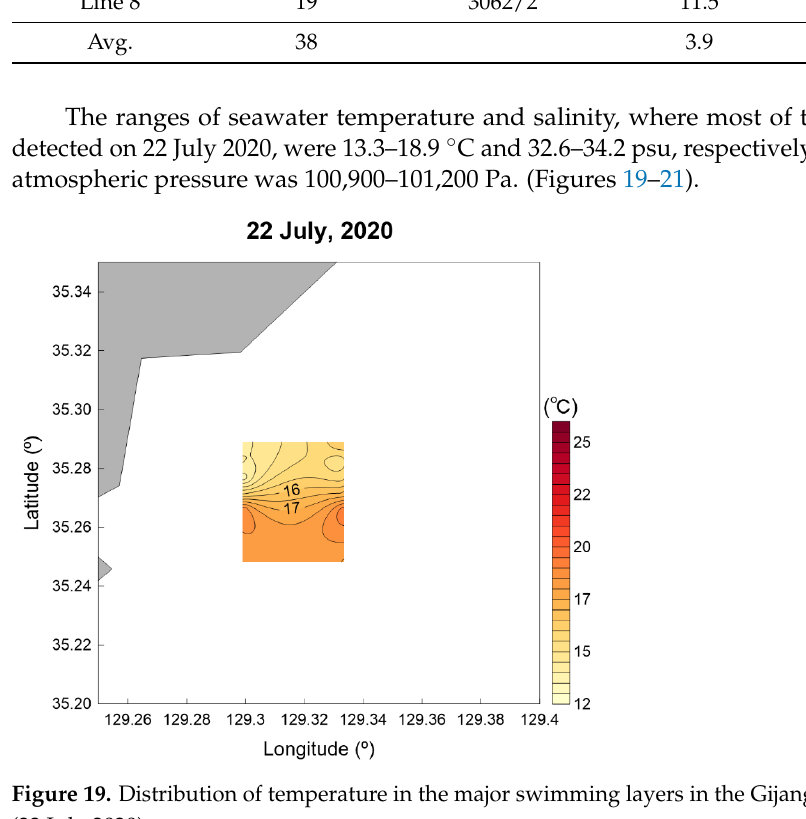
Figure 20. Distribution of salinity in the major swimming layers in the Gijang coastal waters sea (22 July, 2020).